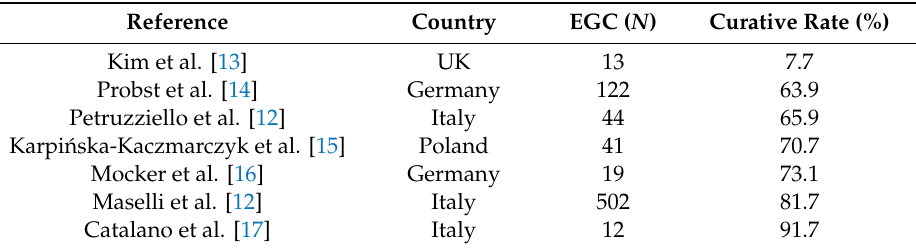
Table 2. Curative rates for early gastric cancer following endoscopic submucosal dissection (ESD) reported in some European